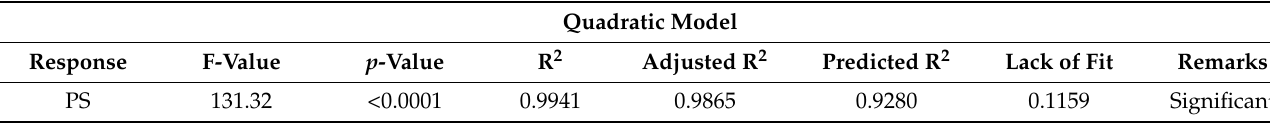
Table 4. Statistical ANOVA results of the quadratic